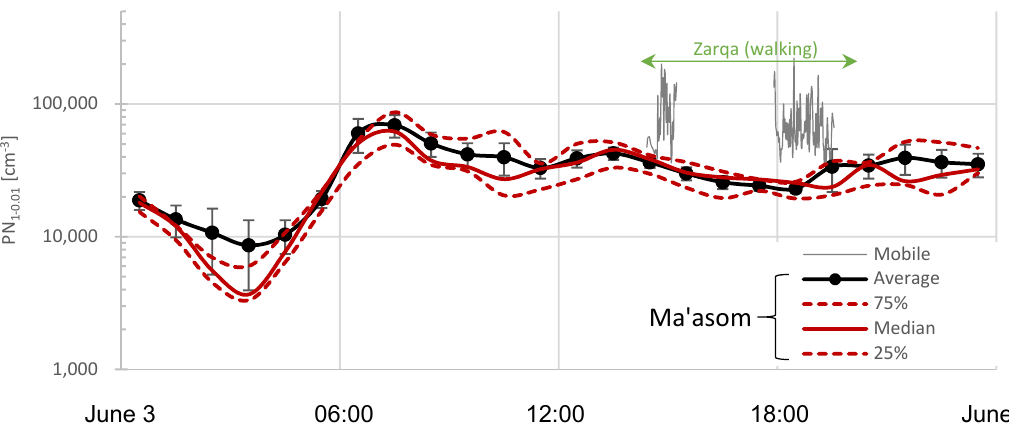
Figure 5. Submicron particle number concentrations (PN 1–0.01 ) measured during walking mobile campaign in Zarqa city center on June 3rd. The results are plotted along with the diurnal pattern observed at the reference urban background (Ma’asom in Zarqa).